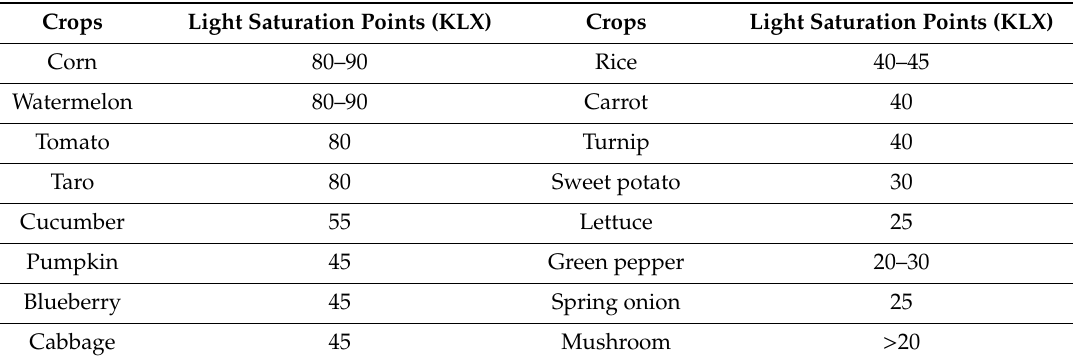
Table 10. Light saturation points of selected crops